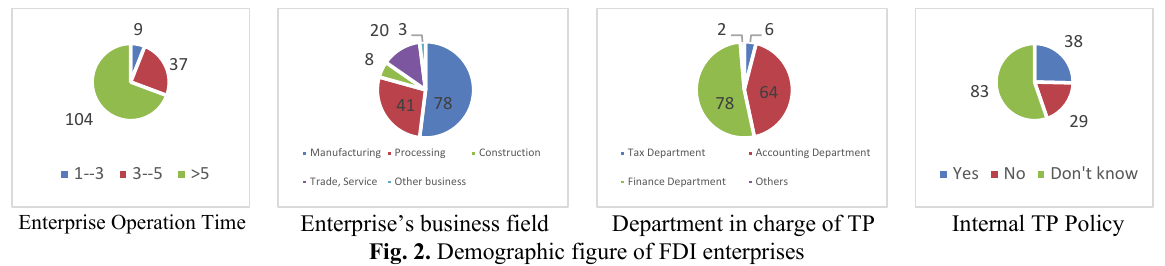
Fig. 2. Demographic figure of FDI